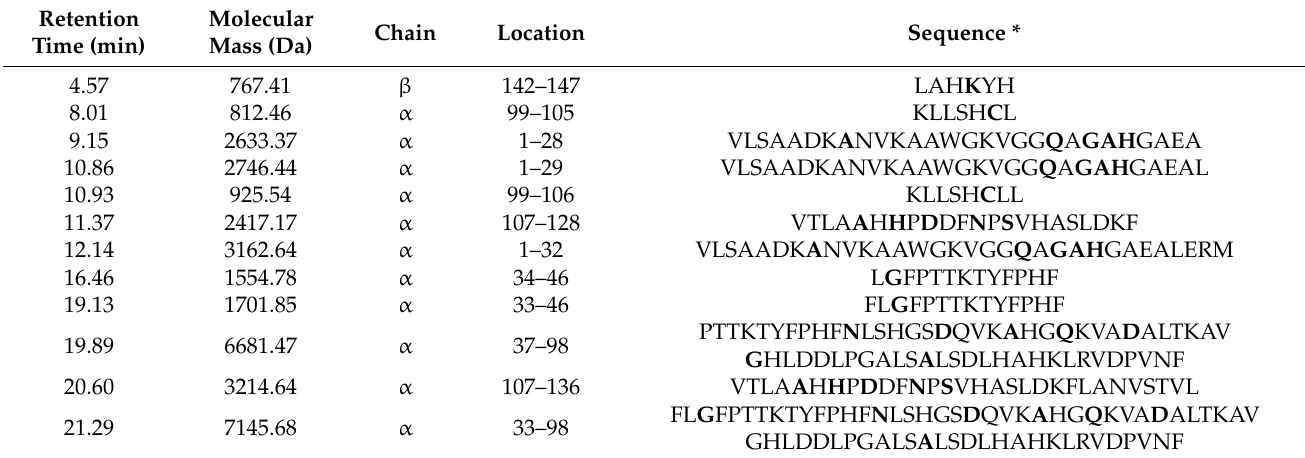
* Amino acids in bold: Differences with bovine hemoglobin sequences, same location on the